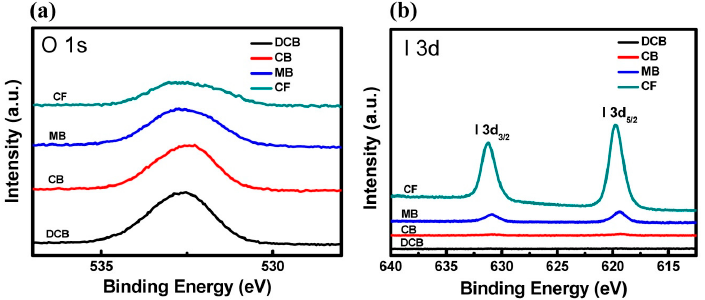
Figure 7. The X-ray photoelectron spectroscope (XPS) ( a ) O1s and ( b ) I3d analysis results for PCBM ETLs based on various solvents.